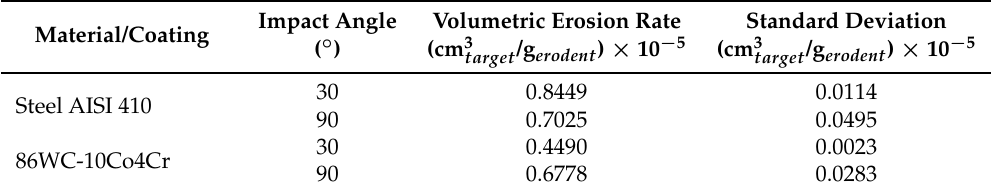
Table 4. Accumulated erosion rate in volume loss.